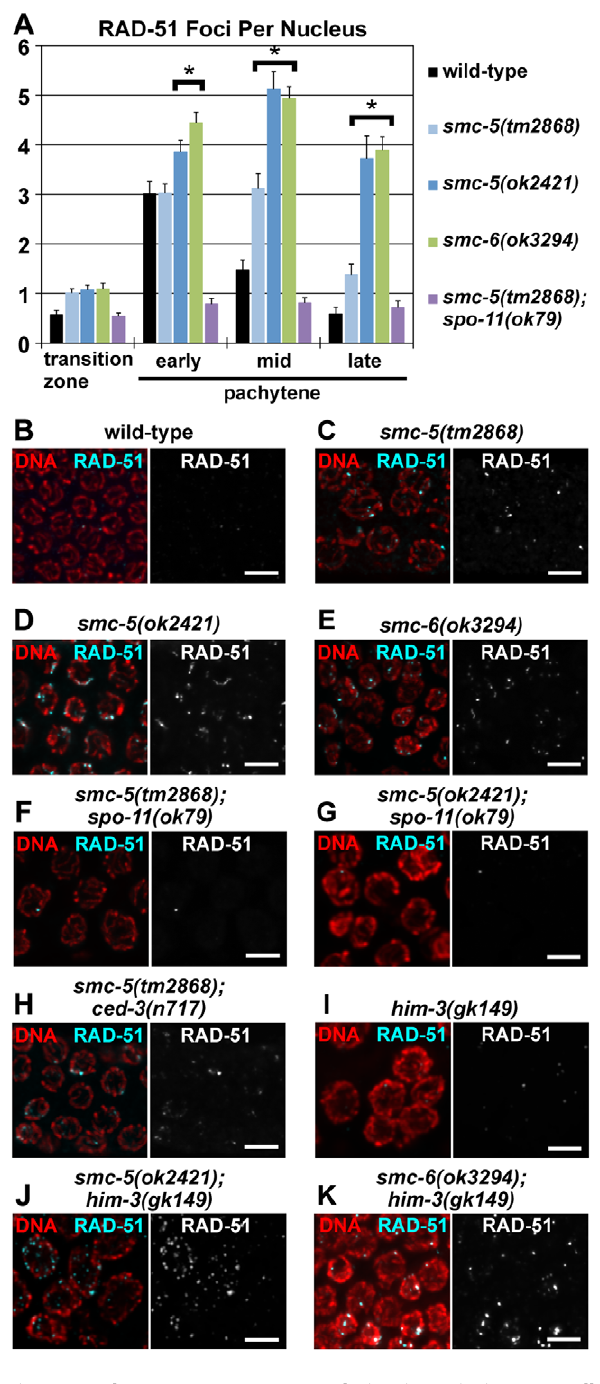
Figure 4. Aberrant RAD-51 accumulation in meiotic germ cells from the smc-5 and smc-6 mutants. (A) The average numbers of RAD-51 foci per nucleus in the transition zone and pachytene regions of the gonad arms are represented in the bar graph; the error bars represent standard errors. The pachytene region was divided into three equal length areas (early, mid and late) and each quantified separately. The smc-5 and smc-6 mutants showed significant increases in RAD-51 foci in comparison to wild-type at the mid- to late-pachytene regions (p # 0.01; two-tailed t-Test). The numerical values and sample sizes are summarized in Table S3. (B–K) Micrographs of RAD-51 immunofluores- cence and DAPI-DNA fluorescence in late pachytene nuclei from the wild-type and the mutant germlines. Scale bars=5 m